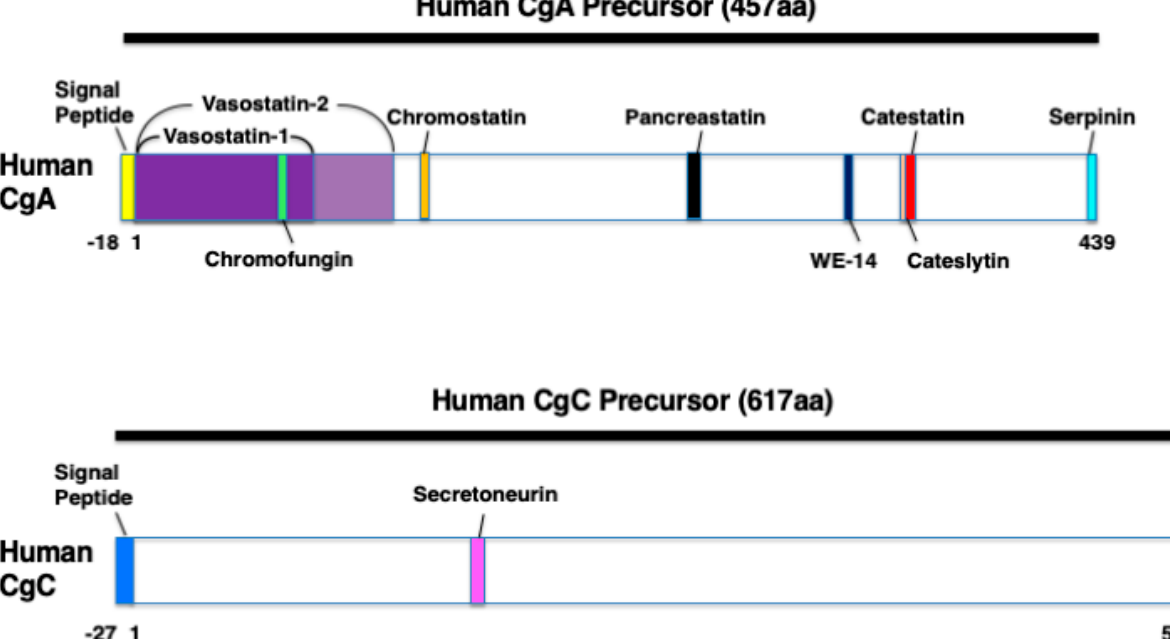
Figure 1. The domains of the various biologically active polypeptides derived from human chromogranin A (CgA) and human chromogranin C (CgC). Schematic diagrams showing vasostatin-1 (CgA1–76), vasostatin-2 (CgA1–113), chromofungin (CgA47–66), chromostatin (CgA124–143), pancreastatin (CgA250–301), WE-14 (CgA324–337), cateslytin (CgA344–358), catestatin (CgA352–372), serpinin (CgA402–439), and secretoneurin (SgII154–186).